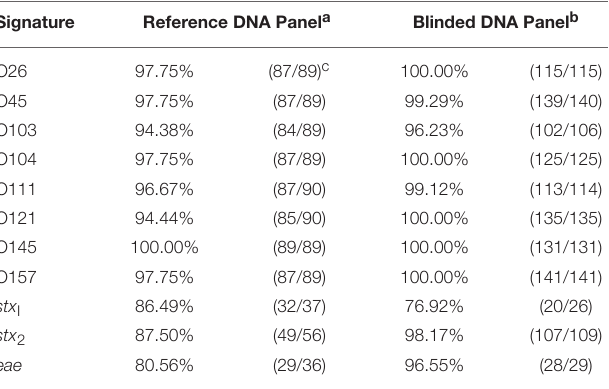
TABLE 2 | Diagnostic specificity of STEC-8 MOL-PCR assay on STEC DNA